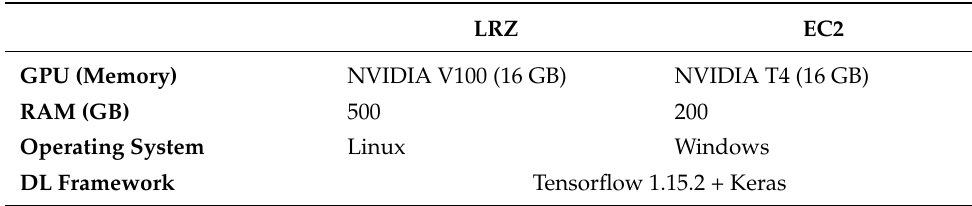
Table 2. Technical details about the developing and testing